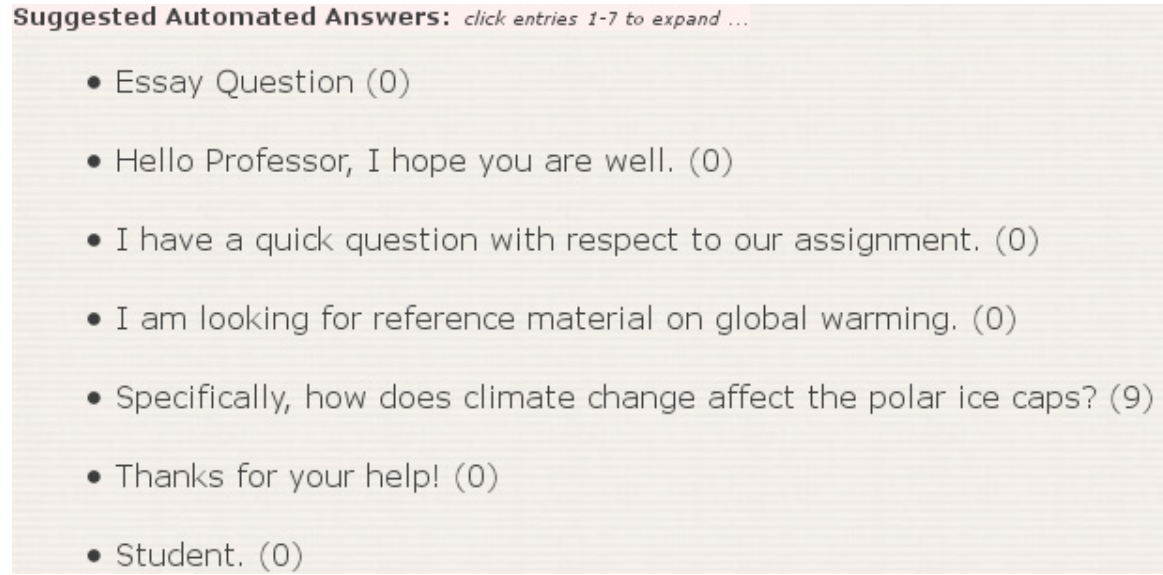
Figure 7 . Submitted message split into sentences and answered by the QA system.